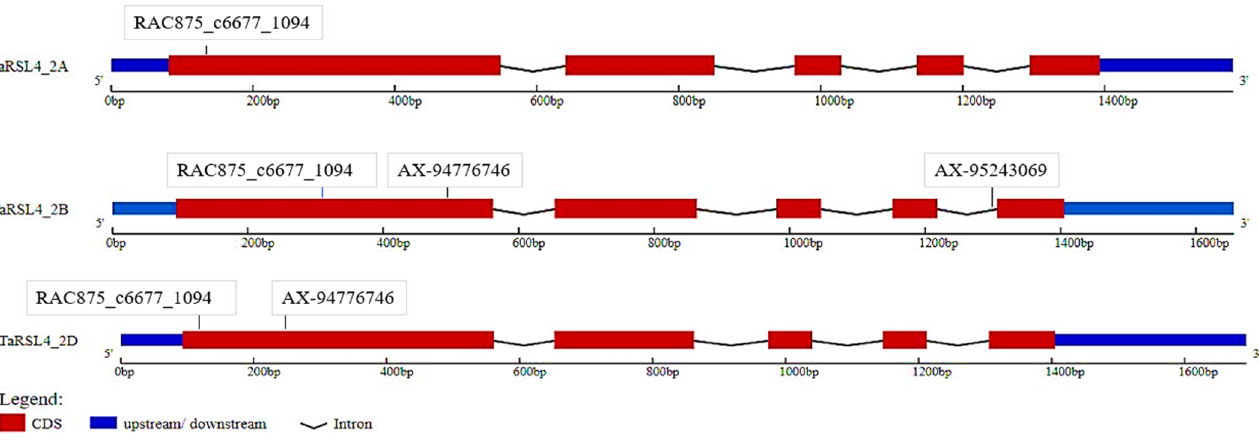
Figure 5. Gene structure of TaRSL4 homoeologues showing position of their respective SNPs.